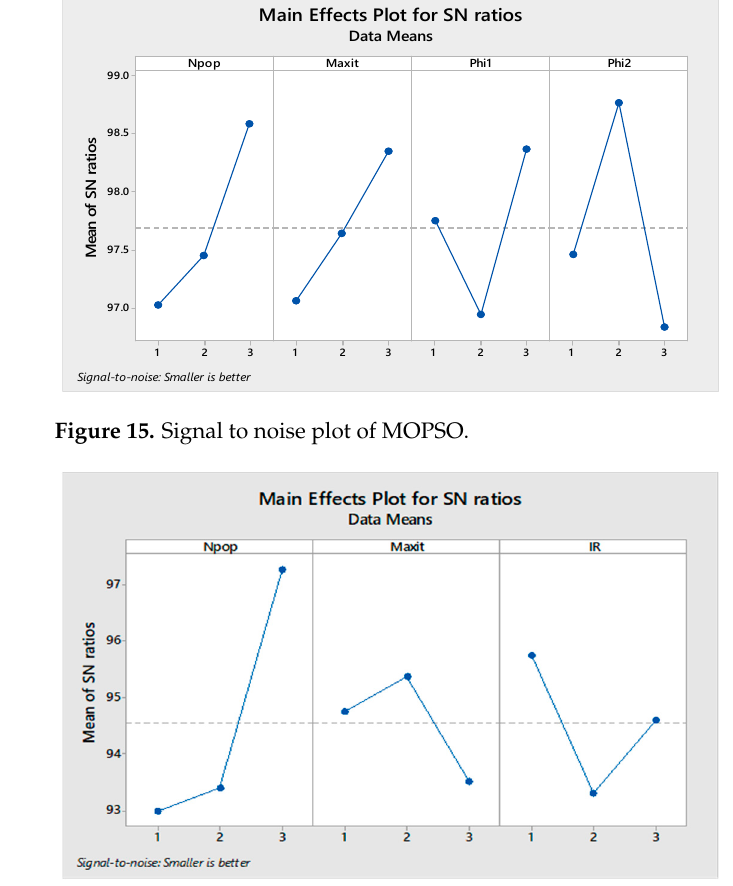
Figure 16. Signal to noise plot of MOGWO.